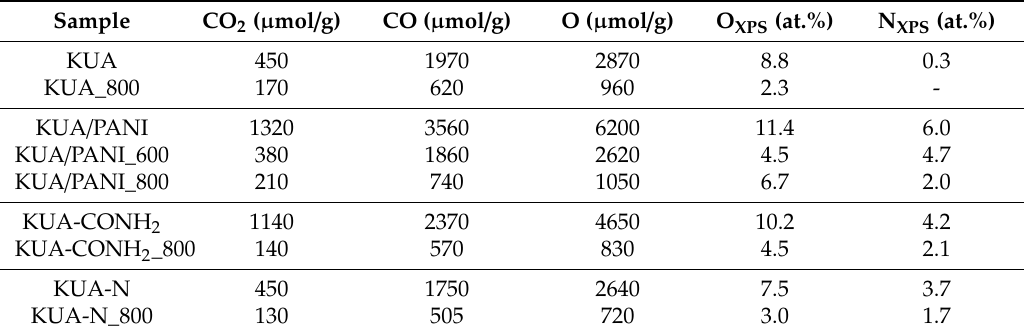
Table 1. Surface composition of the activated carbons obtained by Temperature Programmed Desorption (TPD) and X-ray Photoelectron Spectroscopy